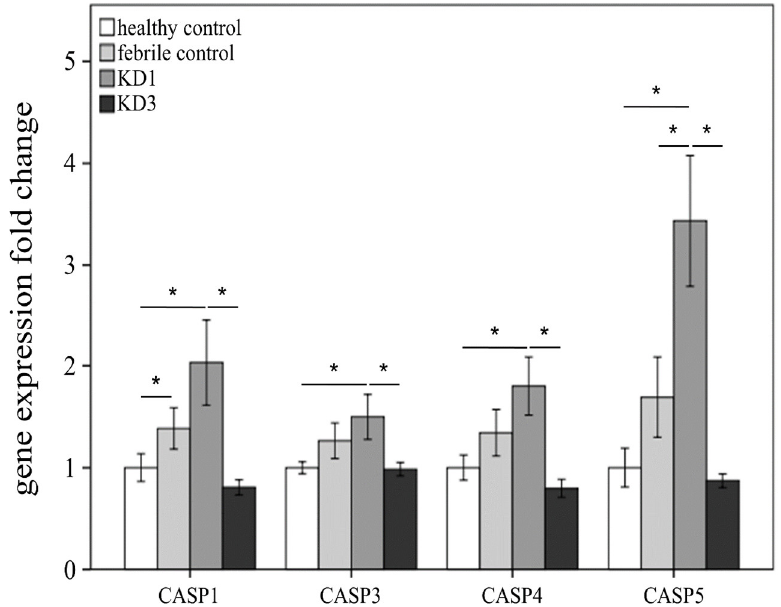
Figure 1. Analyses of caspase mRNA expressions using GeneChip ® Human Transcriptome Array 2.0 (HTA 2.0) between Kawasaki disease (KD) patients and control subjects. The chips that passed